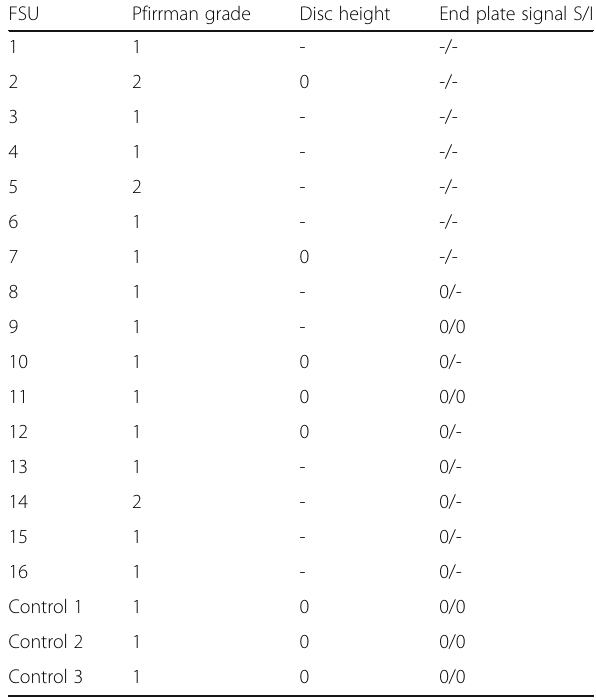
Table 3 MRI of the discs of the loaded FSUs FSU Pfirrman grade